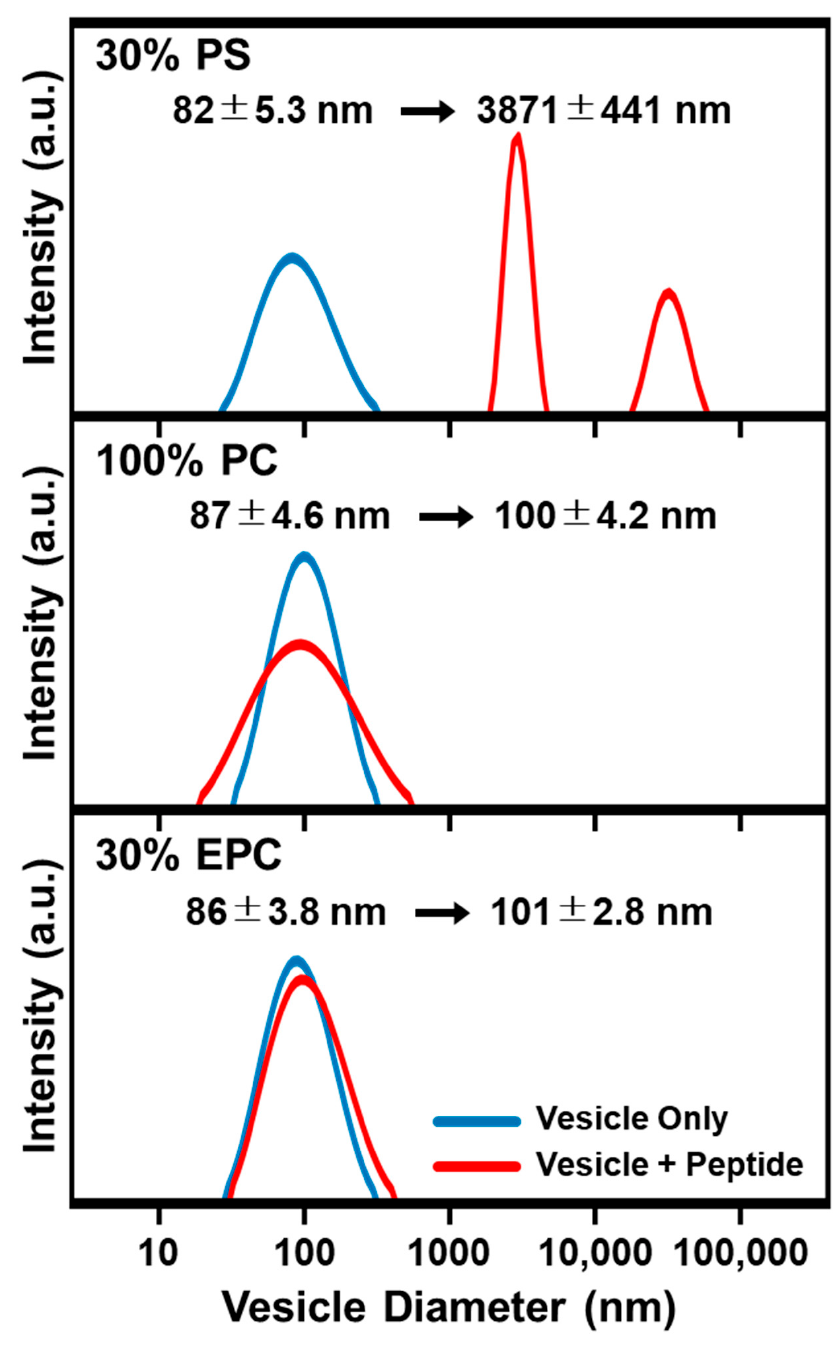
Figure 2. DLS characterization of LTX-315 peptide effects on suspended lipid vesicles with different membrane surface charges. The size distribution of solution-phase lipid vesicles was obtained before (blue lines) and after incubating lipid vesicles with LTX-315 peptide (red lines) by dynamic light scattering (DLS) measurements. Corresponding changes in the size distribution are presented as Gaussian profiles for 70/30 DOPC/DOPS ( top ), 100 DOPC ( middle ), and 70/30 DOPC/DOEPC ( bottom ) lipid vesicles.